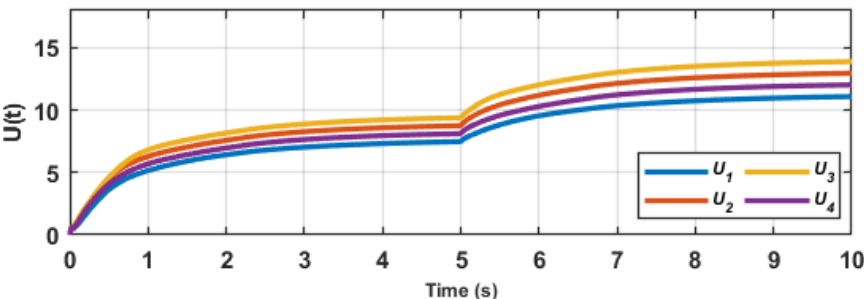
Figure 14. Output of proposed distributed secondary controller under different communication time